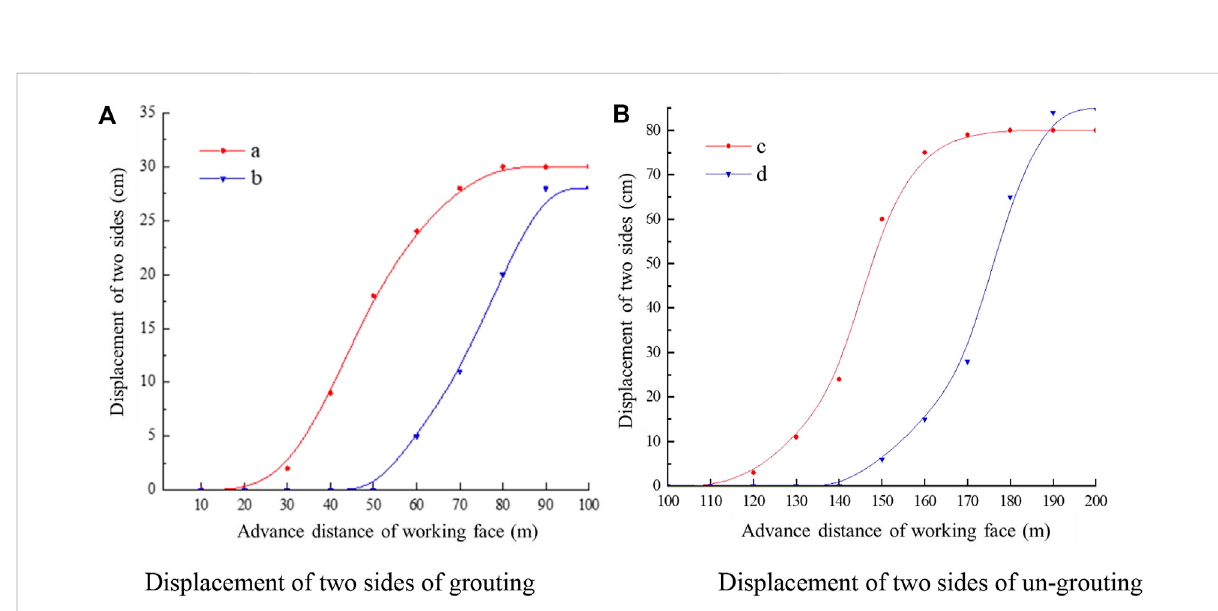
FIGURE 16 Monitoring the amount of migration on both sides of the